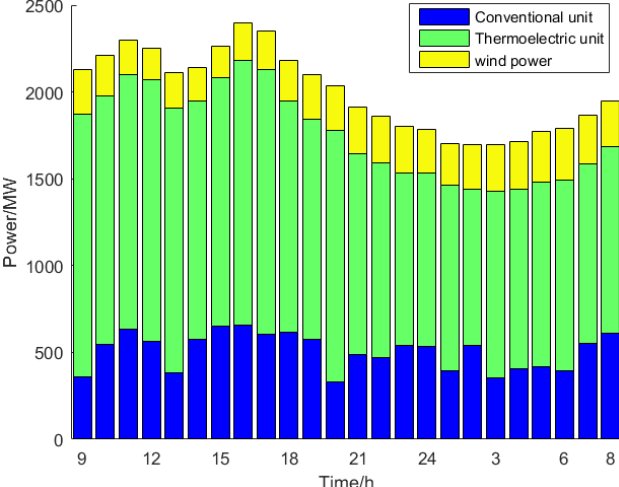
Figure 16. Output of the unit after the addition of the heat storage device.